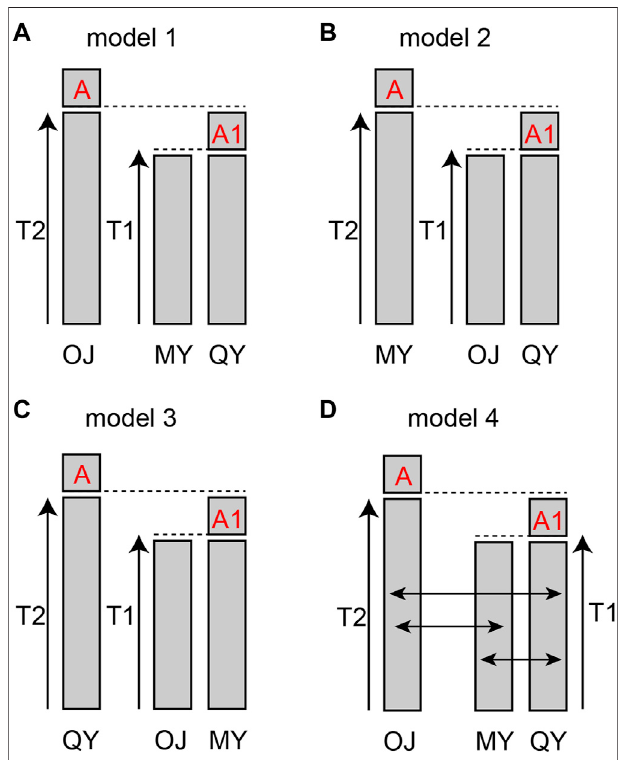
FIGURE 5 | Models of population history of Odontobutis potamophilus . (A) OJ split off fi rst, and the other two groups differentiated later from a common ancestor A 0 . (B) the fi rst population diverged was MY. (C) the fi rst population split off was QY. (D) the gene fl ow parameters added to model 1.